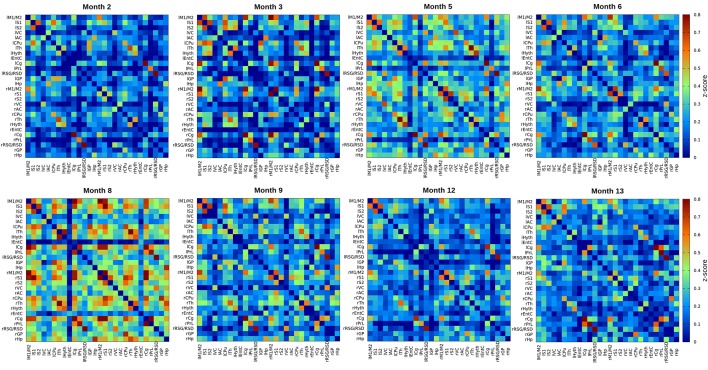
Resting state functional magnetic resonance imaging (rsfMRI) full correlation matrices of the inter- and intra-hemispheric connectivities for 15 regions of interest (ROIs) of the brain. z-score values of cross-correlations are plotted. The eight matrices correspond to 2, 3, 5, 6, 8, 9, 12 and 13 months of age of healthy C57BL/6J mice. There is an overall continuous increase of the power of correlation until month 8, indicated by the color change in the LUT. The correlation power decreases again from month 8 until month 13 (p < 0.001). The 15 ROIs are: S1, primary somatosensory cortex; S2, secondary somatosensory cortex; M1/2, primary and secondary motor cortex; VC, visual cortex; AC, auditory cortex; CPu, caudate putamen; Th, thalamus; EntC, entorhinal cortex; Cg, prelimbic cingulate; PrL, rostral dorsal prelimbic cortex; RSG/RSD, retrosplenial granular and dysgranular cortex; GP, globus pallidus; Hyth, hypothalamus; Hp, hippocampus. “l” prefix indicates left hemisphere, “r” prefix indicates right hemisphere.